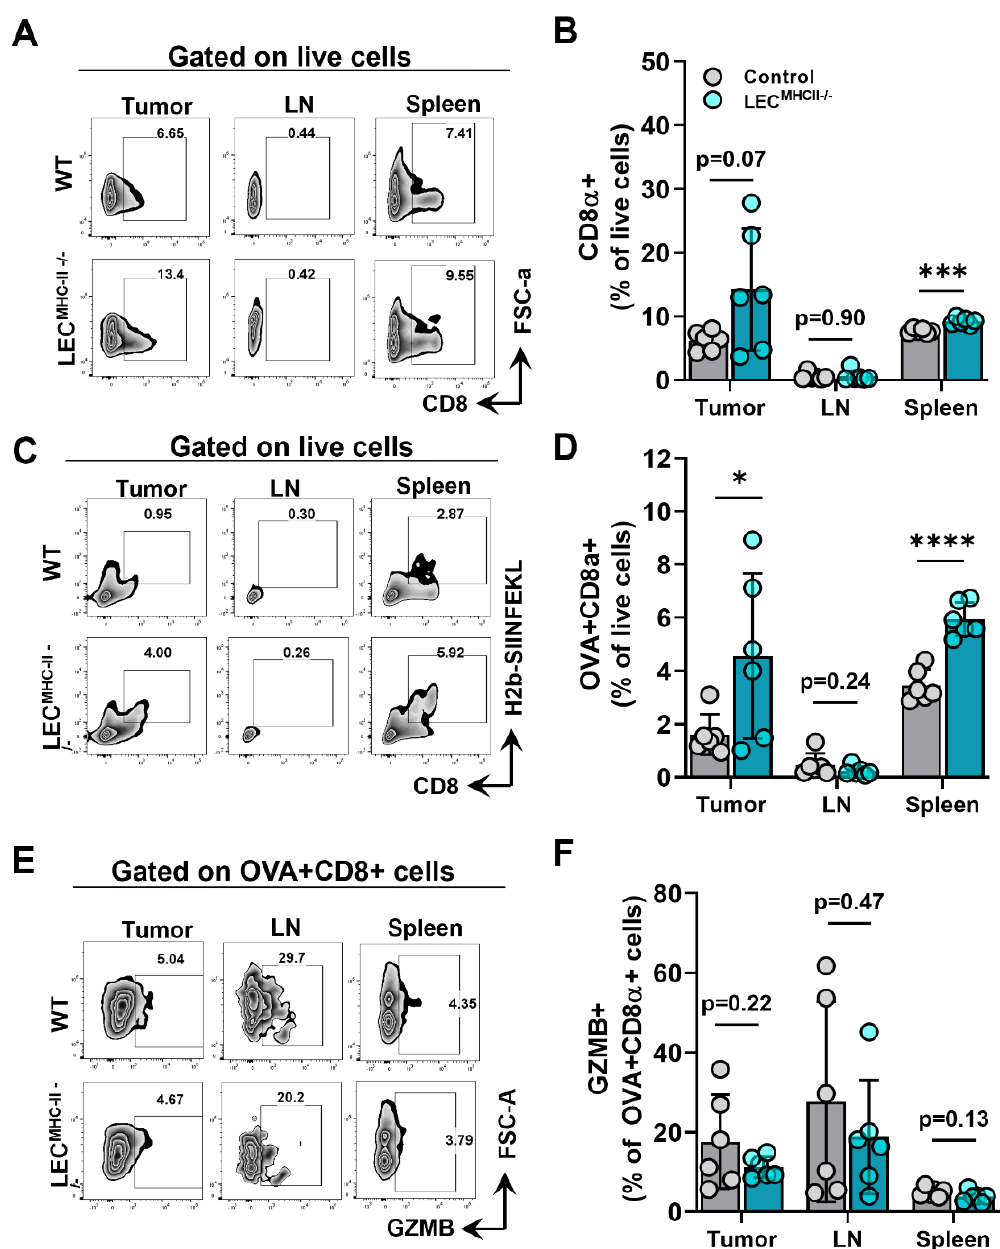
Figure 5. Attenuated tumor growth in LEC-specific MHC-II knockout background is associated with increased number of tumor specific CD8+ TIL. ( A ) Representative FACS plots and ( B ) quantification of CD8 α + cells in the tumor, tumor draining lymph node, and spleen in WT and LEC MHC II − / − mice bearing B16F10-OVA at 12 days post tumor inoculation. ( C ) Representative FACS plots and ( D ) quantification of CD8 α +OVA+ cells in the tumor, tumor draining lymph node, and spleen in WT and LEC MHC II − / − mice bearing B16F10-OVA at 12 days post tumor inoculation. ( E ) Representative FACS plots and ( F ) quantification of granzyme B (GZMB)+CD8 α +OVA+ cells in the tumor, tumor draining lymph node, and spleen in WT and LEC MHC II − / − mice bearing B16F10-OVA at 12 days post tumor inoculation. Statistical significance assessed using unpaired student’s t test on data from at least 5 biological replicates; error represented as SD. *, p <0.05; ***, p < 0.001; ****, p < 0.0001.